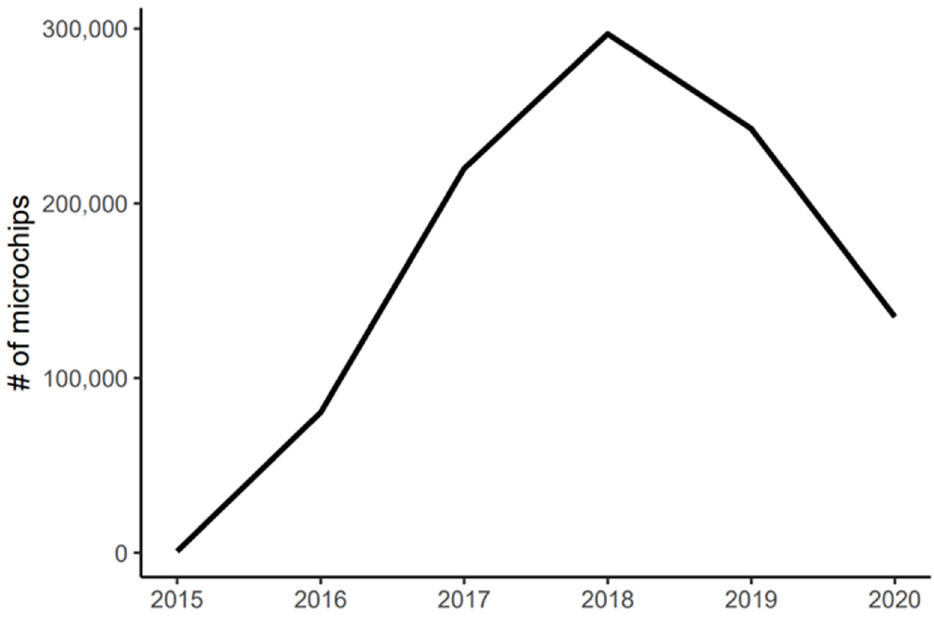
Figure 4. The number of microchipped cats and dogs between 2015 and 2020 shows a steady rise toward 2018 and then a decline into 2020.